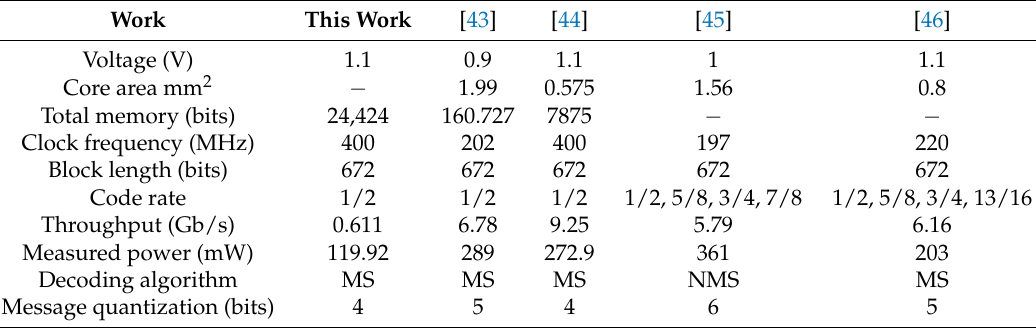
Table 6. Comparison of IEEE802.11ad standard